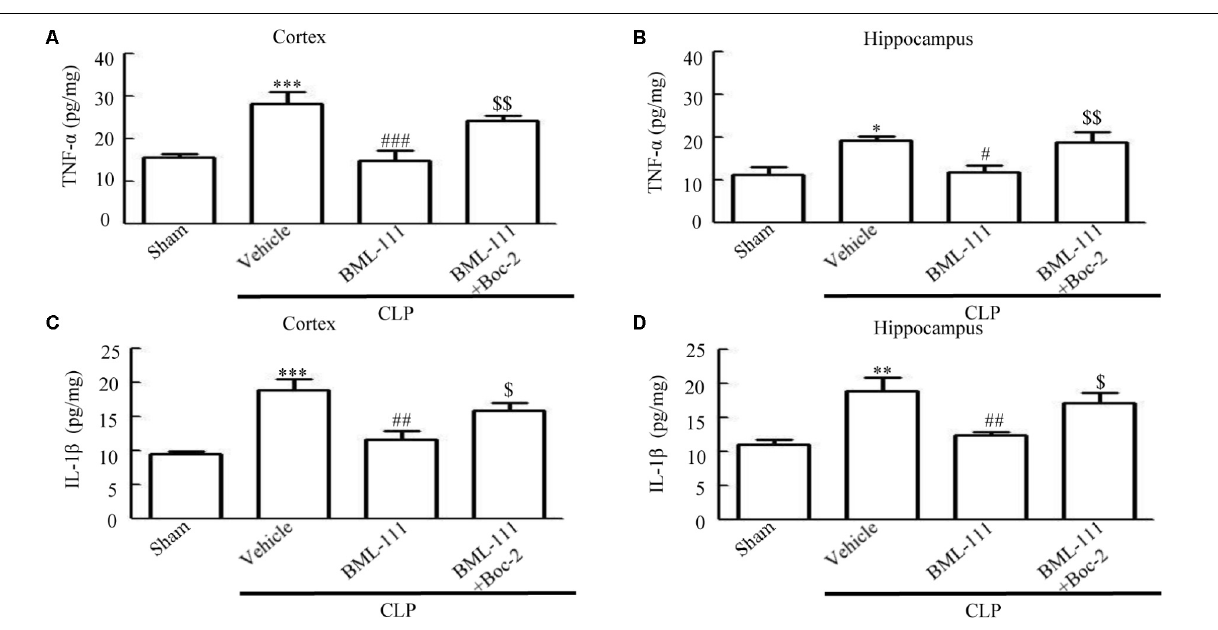
FIGURE 7 | BML-111 treatment reduces the expression of inflammatory cytokines. (A–D) The TNF- α and IL-1 β levels were significantly increased in CLP mice compared with the sham group. BML-111 treatment reduced the cytokine levels when compared with the CLP + vehicle group, and Boc-2 reduced the effects of BML-111. Data were shown as the means ± SEM ( n = 8 surviving mice in A,B , n = 6 surviving mice in C,D ). ∗ P < 0.05, ∗∗ P < 0.01, ∗∗∗ P < 0.001 represent CLP + Vehicle vs. Sham, # P < 0.01, ## P < 0.01, ### P < 0.001 represent CLP + BML-111 vs. CLP + Vehicle, $ P < 0.05, $$ P < 0.01 represent CLP + BML-111 + Boc-2 vs. CLP +